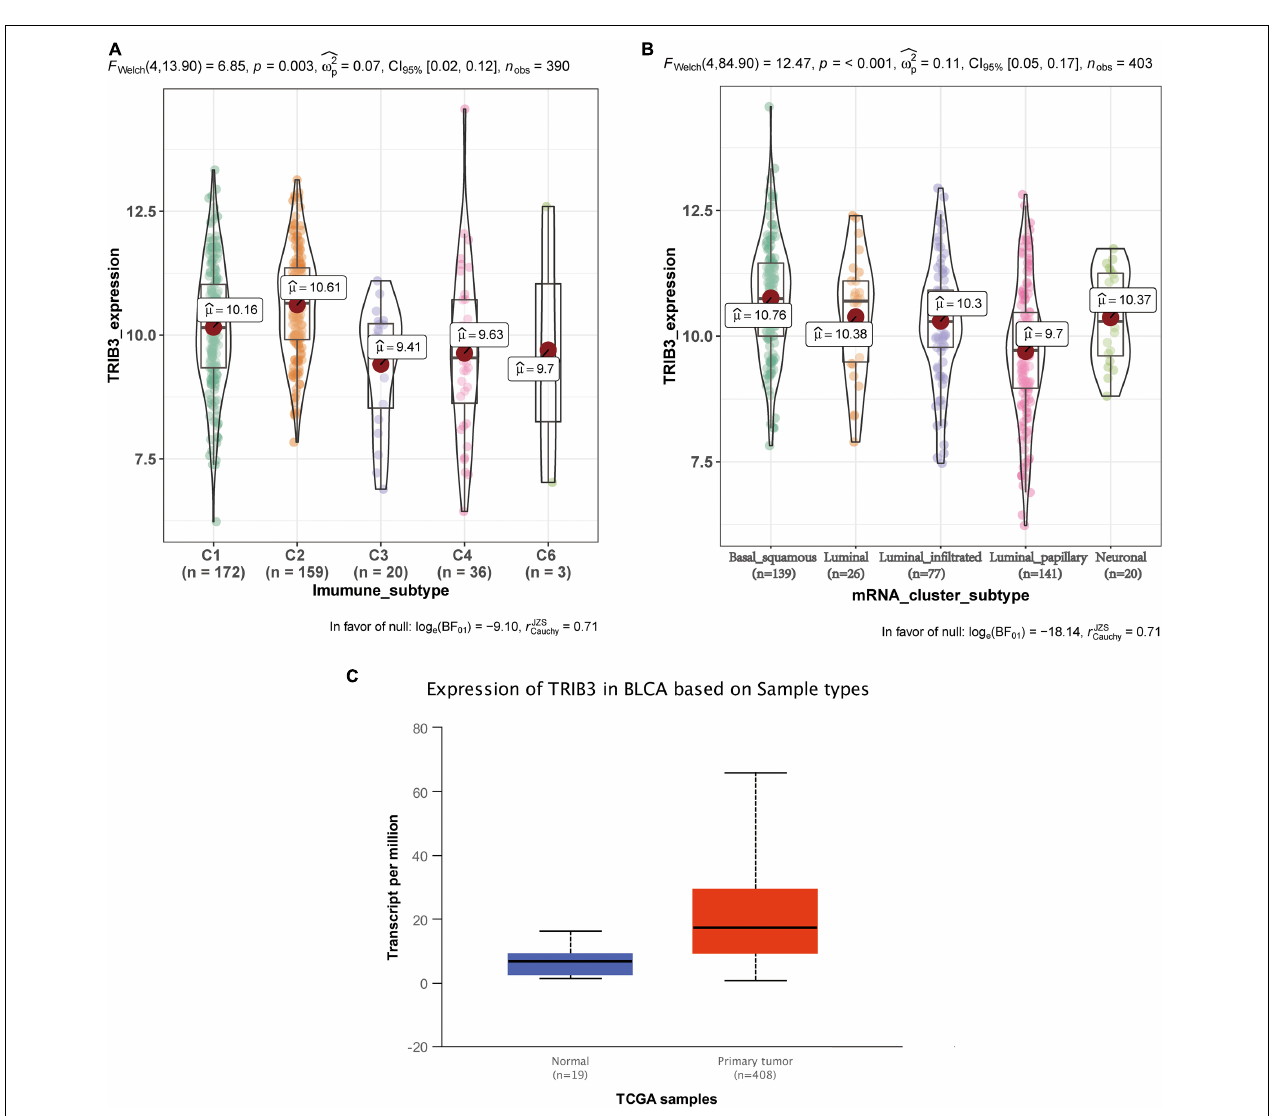
FIGURE 4 | The differential expression of TRIB3 in other typing schemes. (A) Expression levels of the five immunophenotypes: C1 (wound healing), C2 (IFN-gamma dominant), C3 (inflammatory), C4 (lymphocyte depleted), and C6 (TGF-b dominant). (B) Expression levels in five mRNA types: basal squamous, luminal, luminal infiltrated, luminal papillary, and neuronal subtype. (C) Comparison of expression levels of TRIB3 in normal tissue and tumor tissue. p < 0.001 indicates statistical significance.